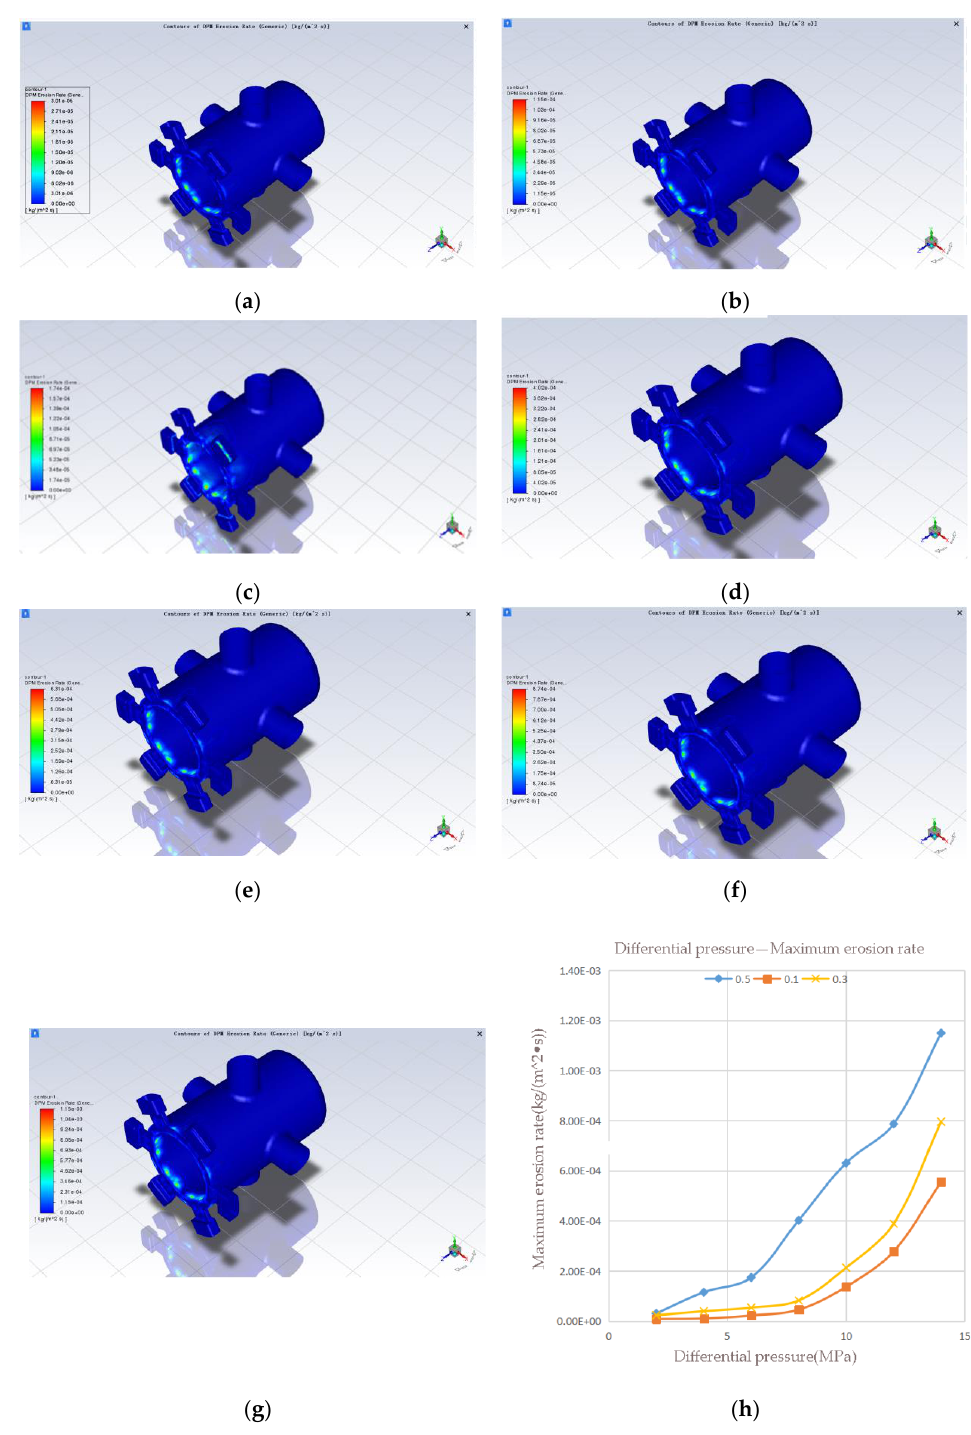
Figure 11. Effect of different pressure differentials on erosion wear: ( a ) 2 MPa; ( b ) 4 MPa; ( c ) 6 MPa; ( d ) 8 MPa; ( e ) 10 MPa; ( f ) 12 MPa; ( g ) 14 MPa; ( h ) curve of maximum erosion rate as a function of differential pressure.